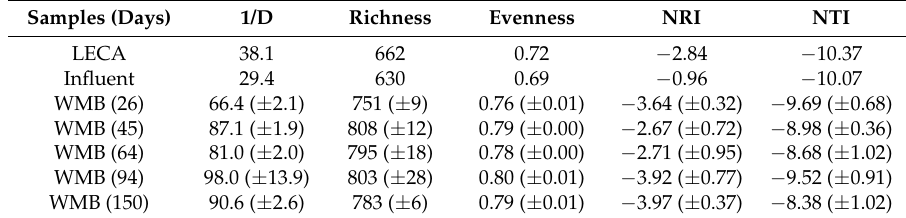
Table 2. Diversity indices of bacterial communities. The values are given for the Inverse Simpson’s diversity (1/D), richness (refers to the number of OTUs at the 95% similarity level), evenness, Net Relatedness Index (NRI), and Nearest Taxon Index (NTI) for initial LECA, influent of HSSF MCs (on day 26 of the experiment), and wetland media biofilm (WMB; n = 3; standard deviations are given in parentheses) of bacterial communities. OTU, operational taxonomic units; LECA, light expanded clay aggregates.